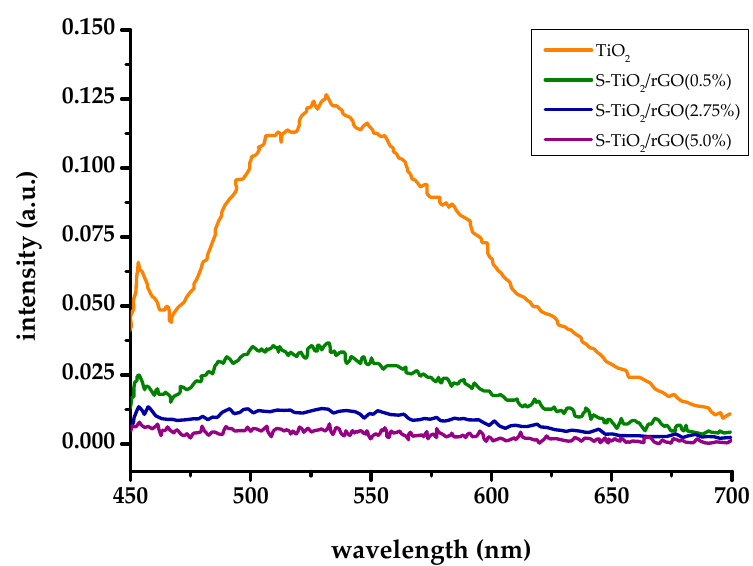
Figure 6. Photoluminescence (PL) spectra of TiO 2 and S-TiO 2 / rGO composites.